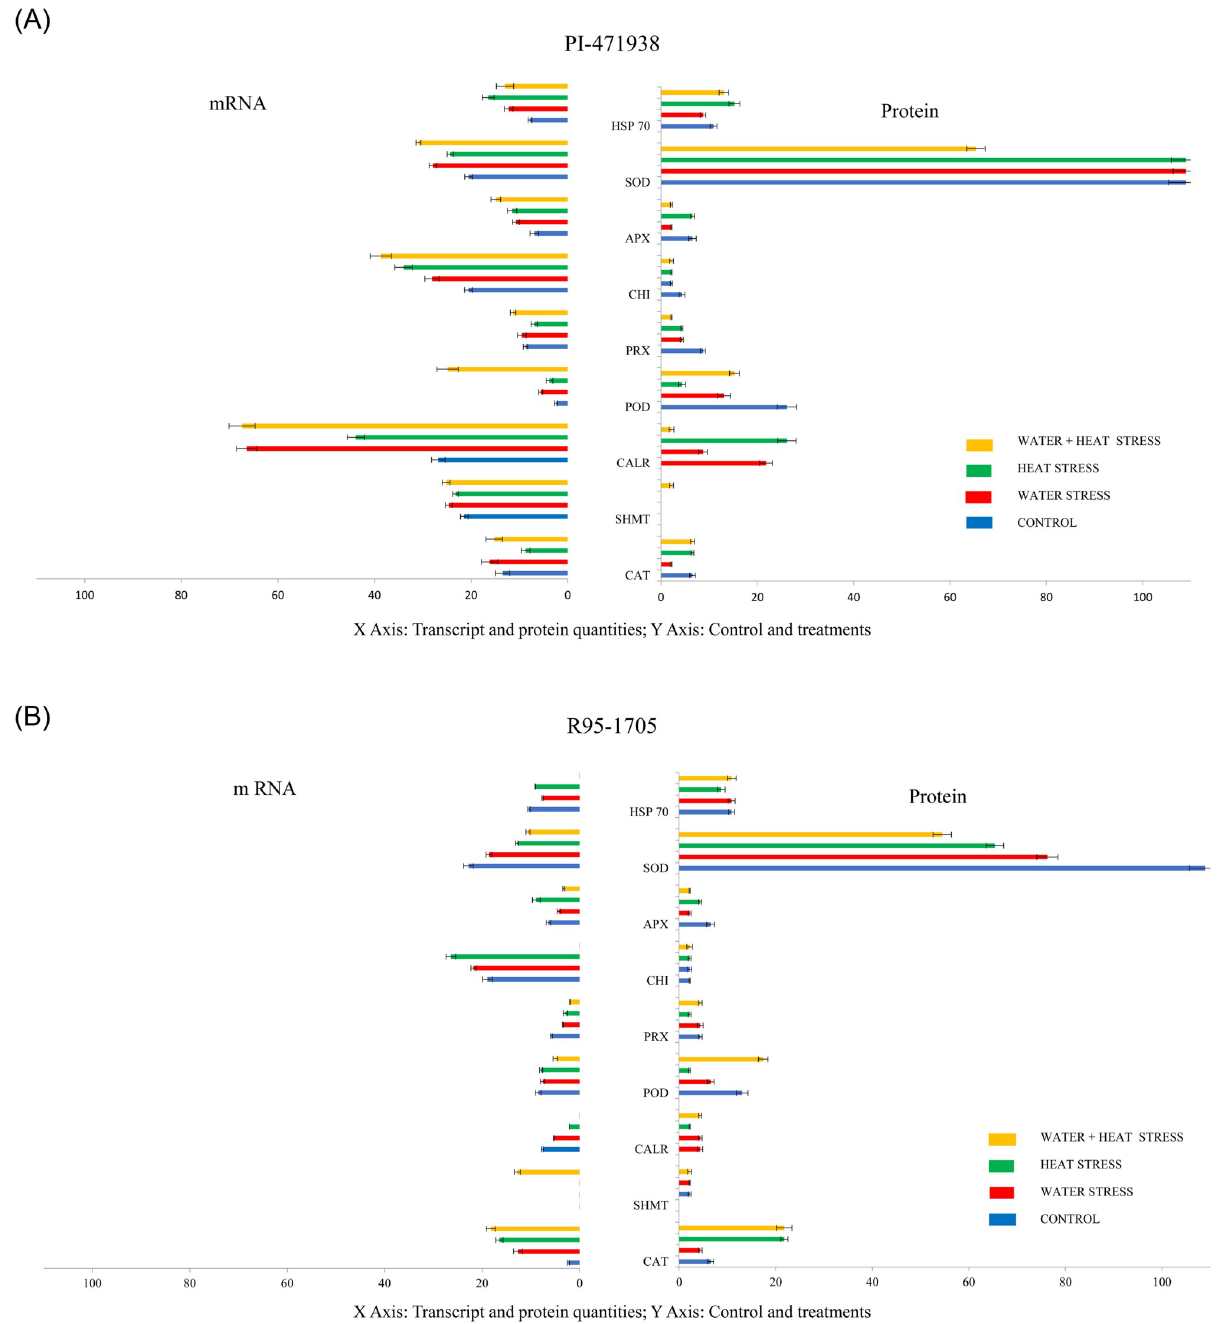
Fig 9. Changes in transcript levels and their protein abundance in response to various stresses in in soybean leaf of (A): PI-471938 and (B): R95- 1795 soybean cultivars. Relative mRNA abundances were normalized against actin gene abundance. Stress 1: Water Stress; Stress 2: Heat Stress, and Stress 3: Water + Heat stress respectively. Data was normalized using the Actin gene Ct value, and extent of change was calculated using the Ct value of the calibrator (control samples -no stress treatment) using the formula 2- ΔΔ Ct.